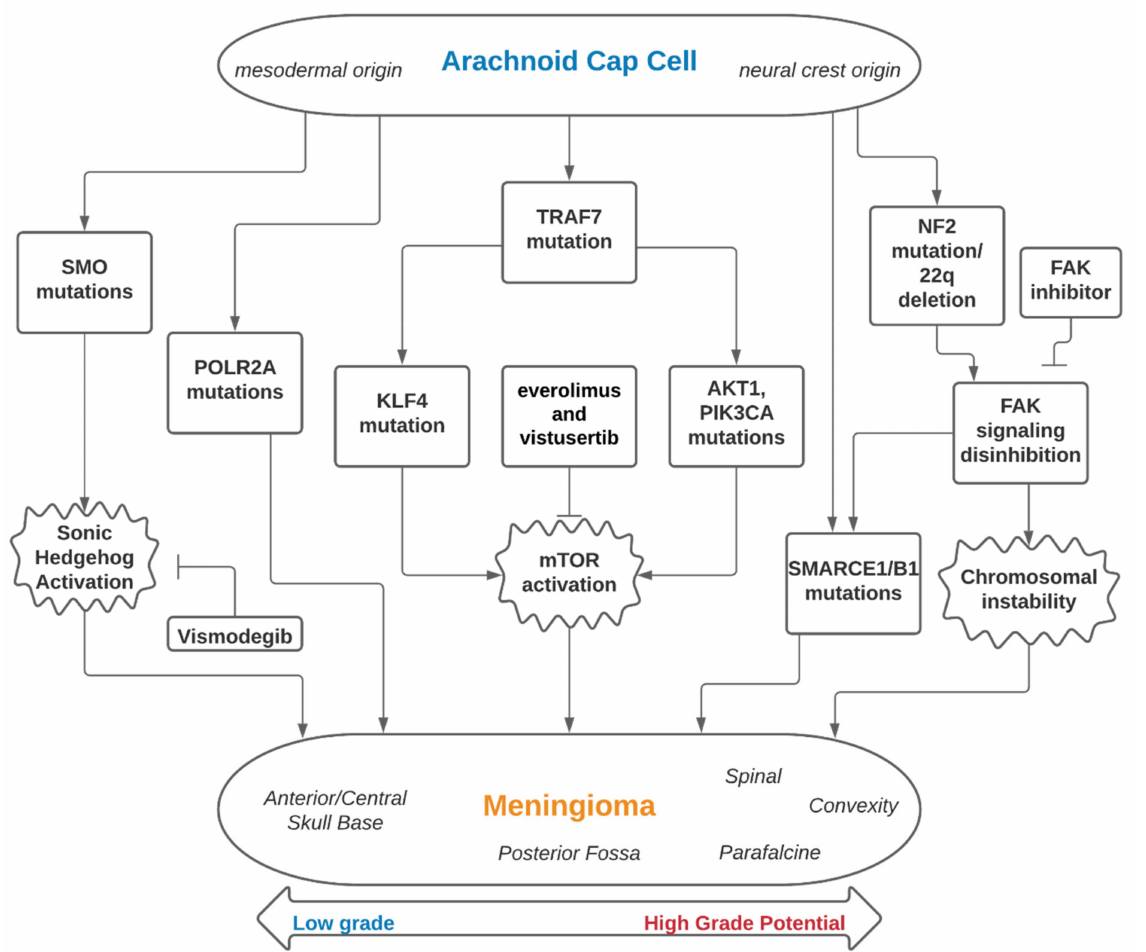
Figure 1. Embryology, genomics and therapeutic interventions of